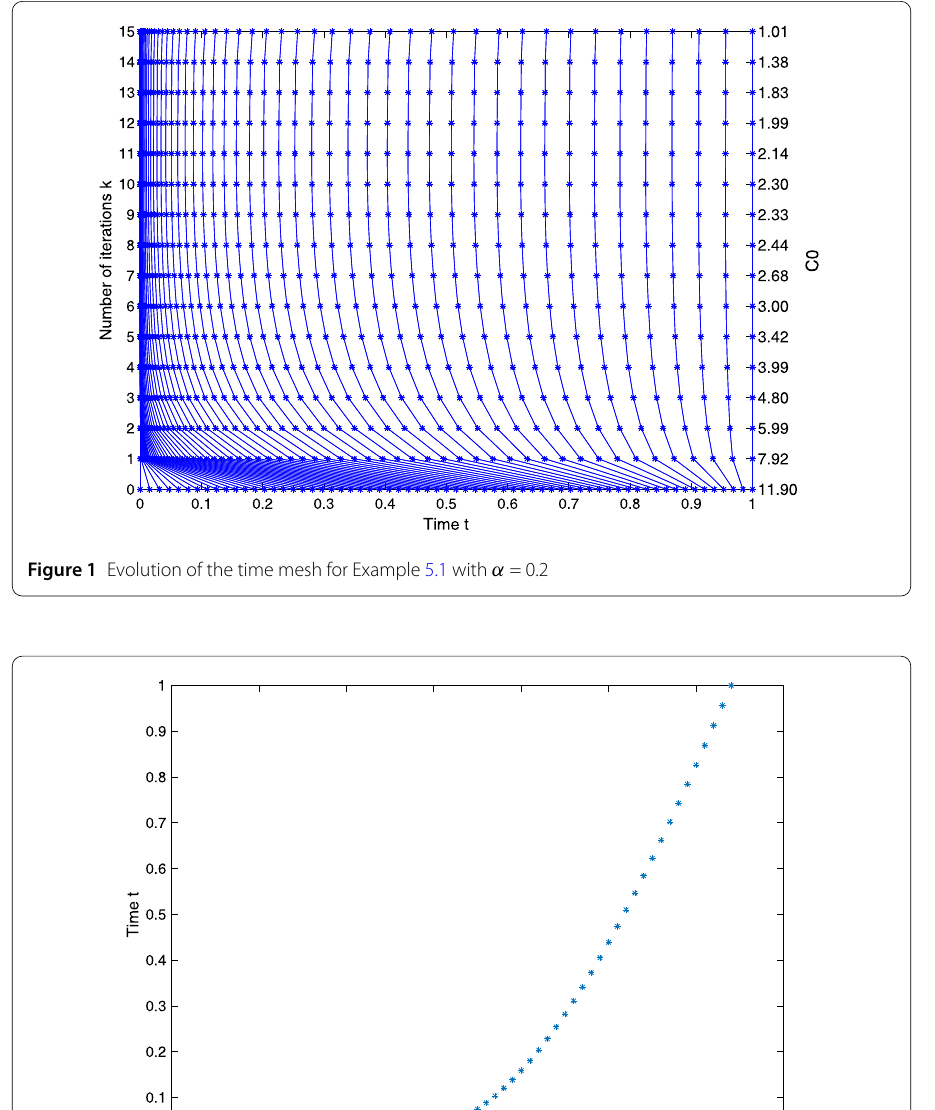
with parameters: σ = 0.3(1 + t ), r = 0.04(1 + sin t ), E = 10, T = 1 and X = 40. The double mesh principle is used to estimate the errors and compute the experiment ¯ U N , K ( x , t ) be a linear interpolation of the approximated solution convergence rates. Set } with spatial discretization parameter N and time discretization parameter K and { U j i ¯ ¯ U N , K ( x i , t j ) be the value of the function U N , K ( x , t ) at mesh point ( x i , t j ). Then the maximum errors